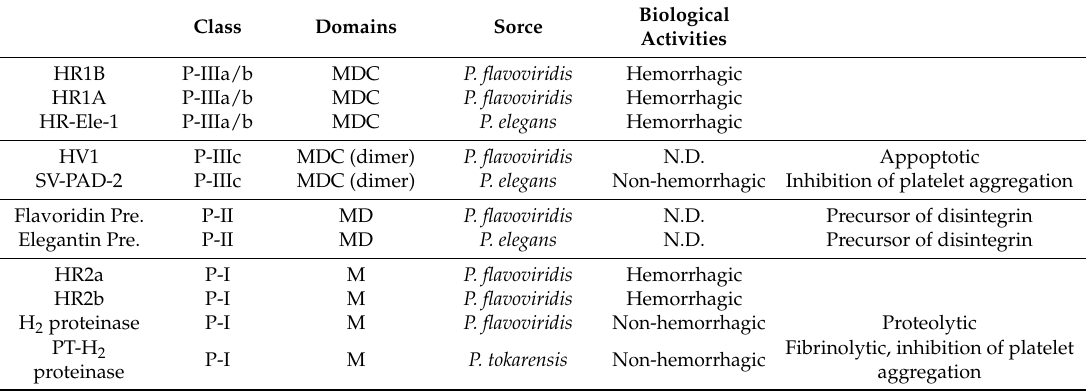
Table 1. Characterizations and biological activities of SVMPs from Protobothrops venom in